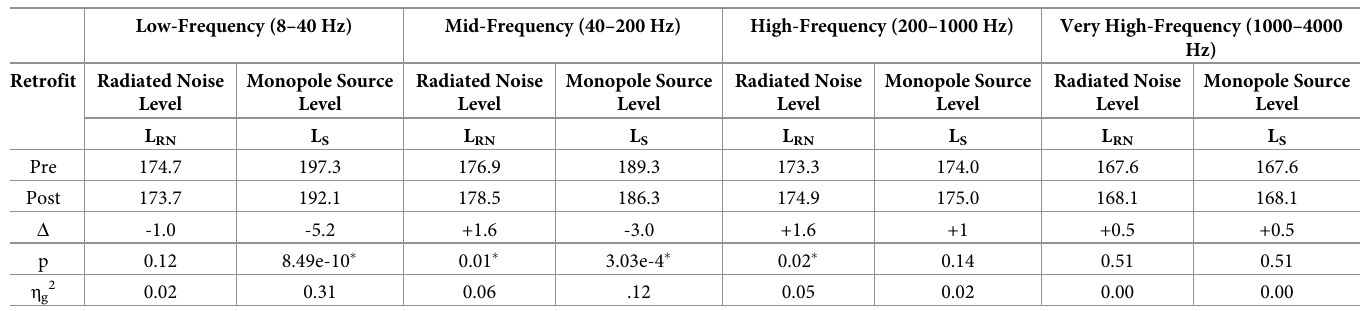
Table 2. Radiated noise levels and monopole source levels pre- and